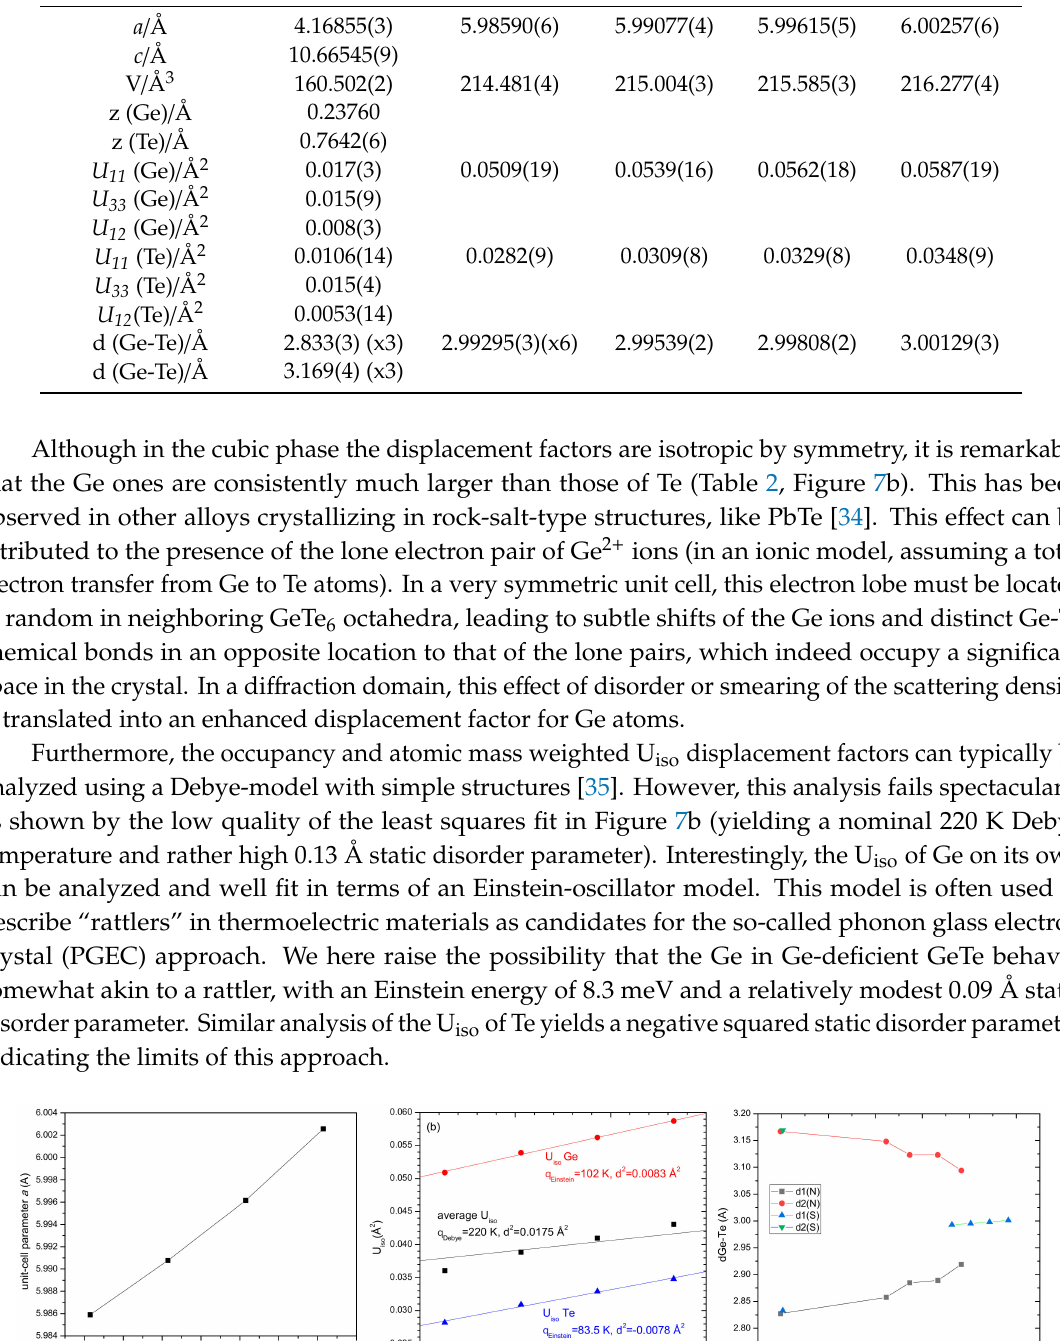
Main structural parameters after the Rietveld refinement from NPD data for GeTe: rhombohedral ( R3m ) at 303 K and cubic ( Fm-3m ) at 663 K and above. Temperature (K) 303